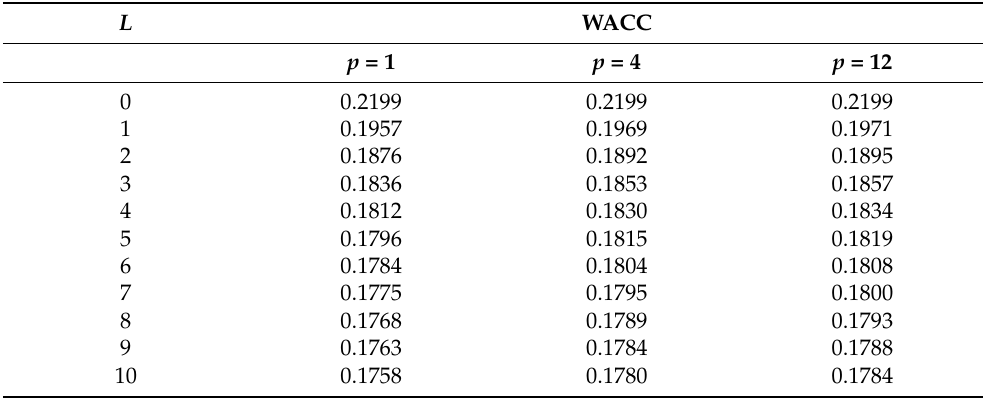
Table 2. Change of the weighted average cost of capital, WACC, with leverage, L , for k d = 0.14, k 0 = 0.22, p = 1, 4, and 12, and n =